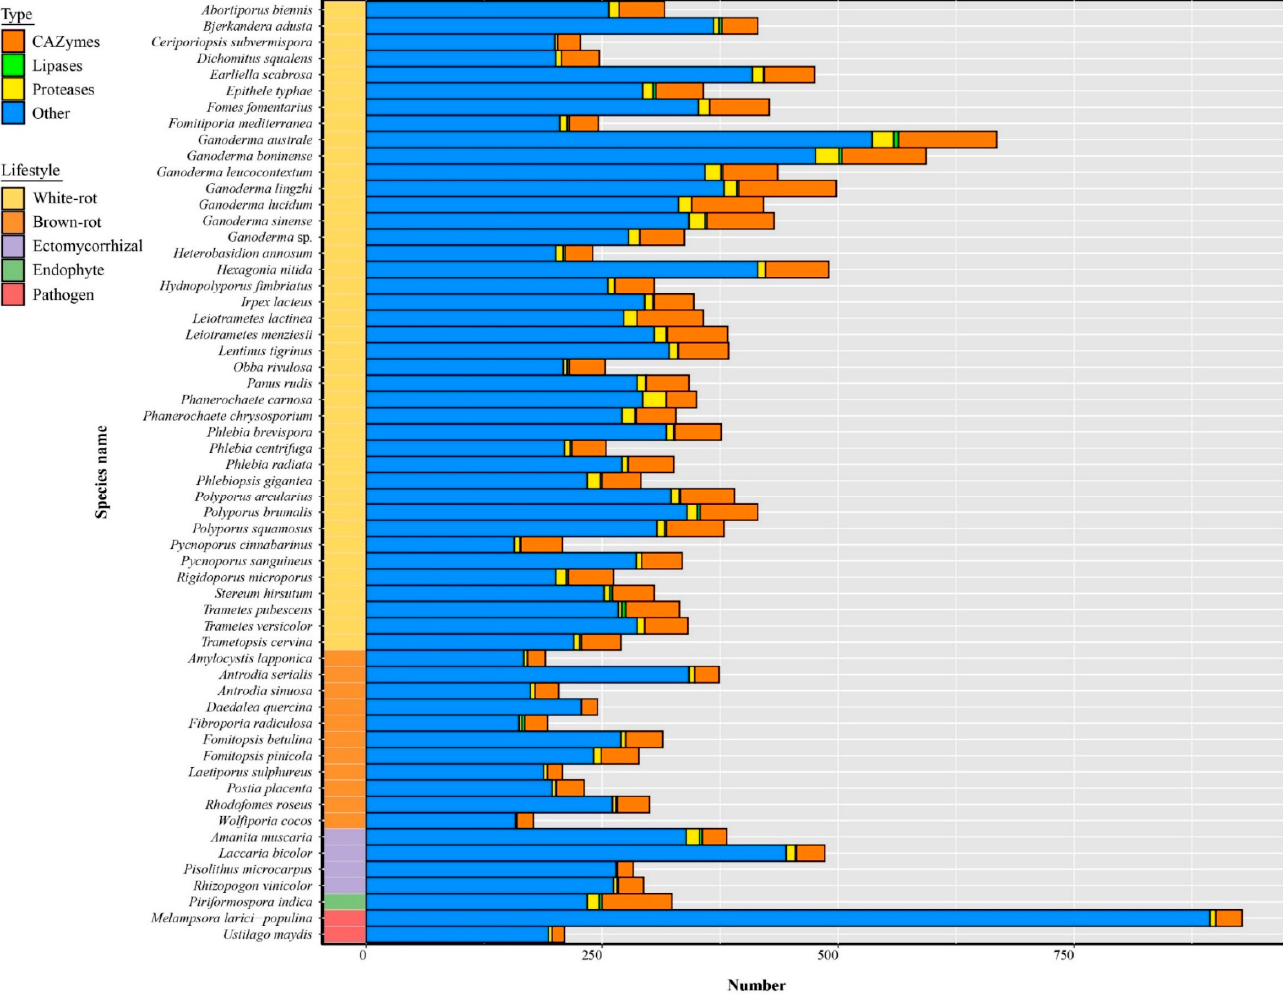
Figure 8. Distribution of small secreted proteins (SSPs) in Ganoderma species and other selected fungi. Bars represent the number of annotated (CAZymes, lipases, proteases) and other SSPs. All species are annotated by five lifestyles.